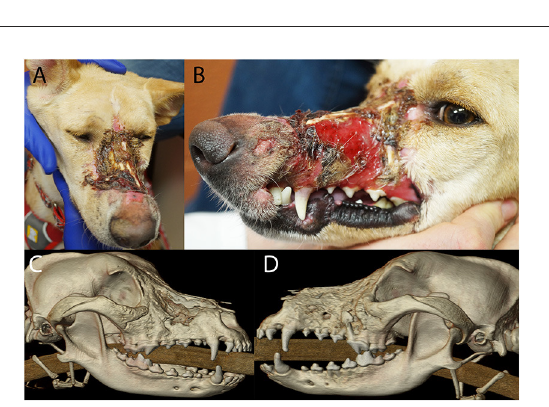
FIGURE7 3D model of a surgical guide for mandibulectomy and reconstruction.